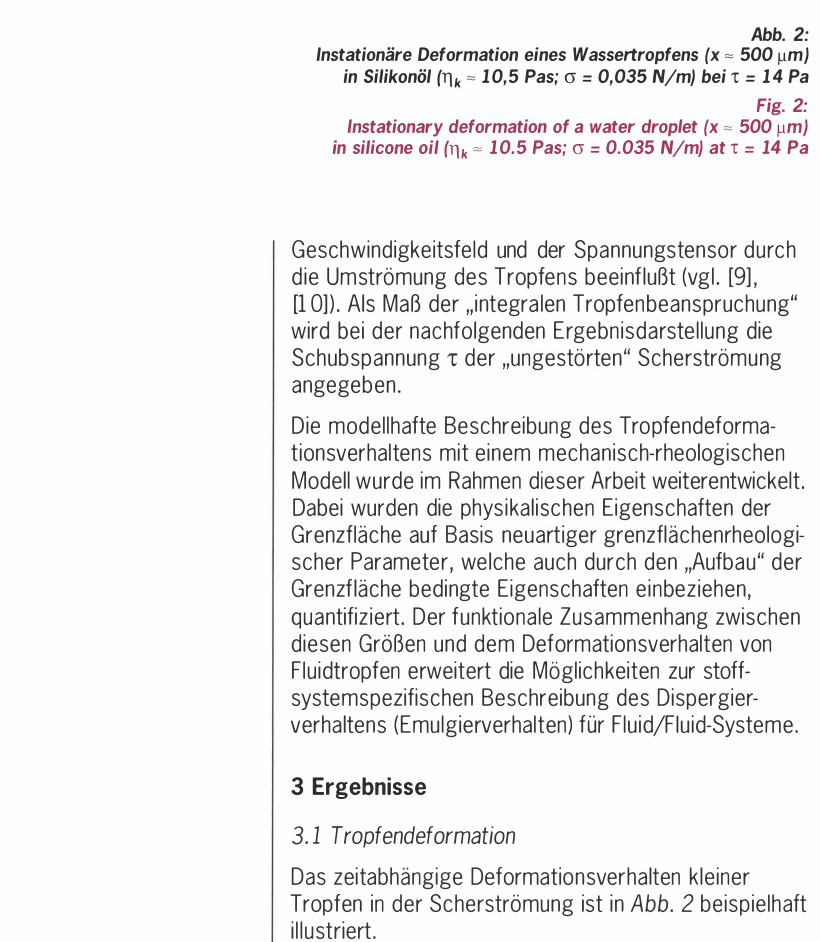
lnstationary deformation of a water droplet (x � 500 �m) in silicone